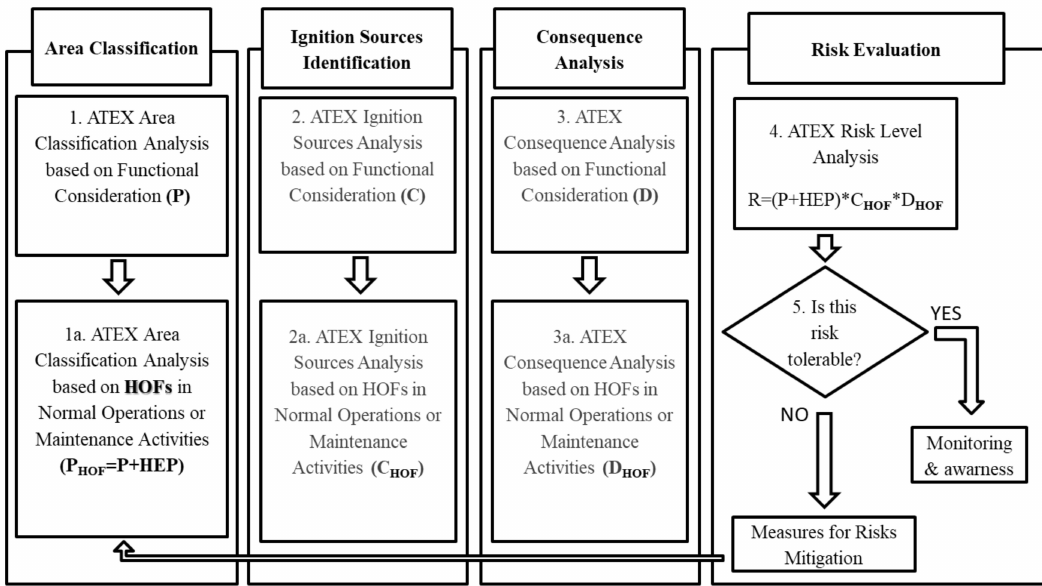
Figure 3. Proposed framework for explosive atmosphere (ATEX) risk